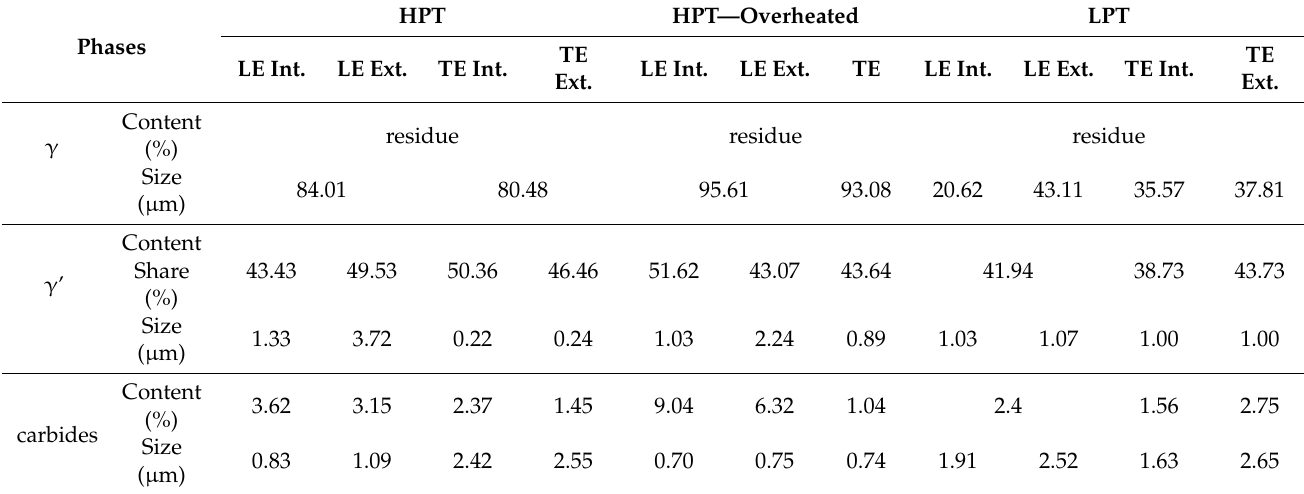
Table 4. Volume content and grain size of individual phases i006E of the structure of the analyzed blades.